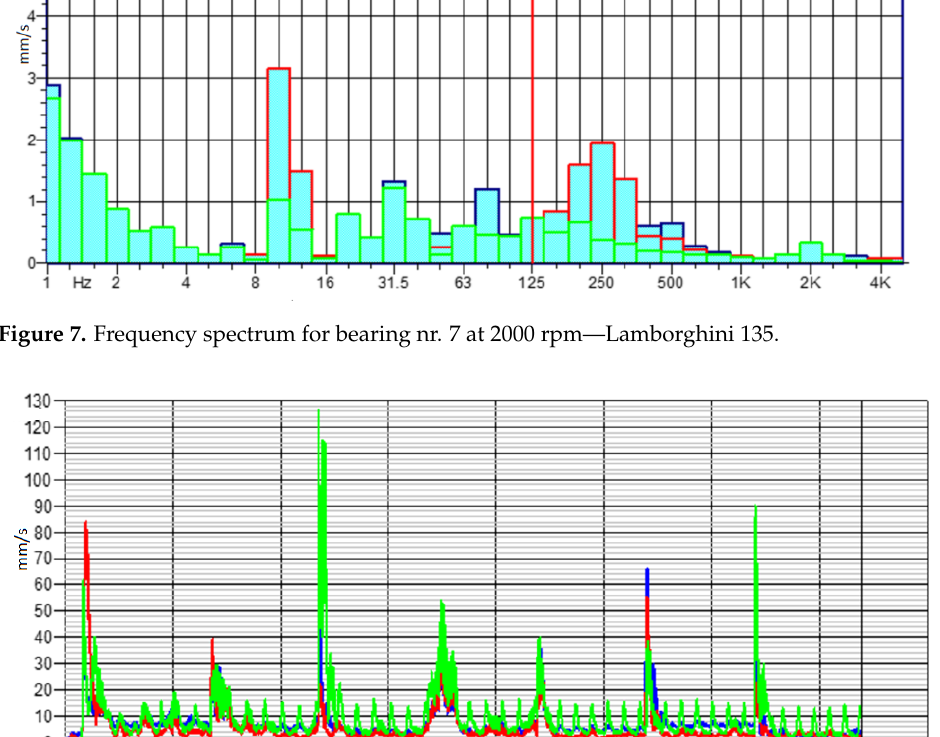
Figure 8. Overall time history at 600 rpm — Fiat 55l.